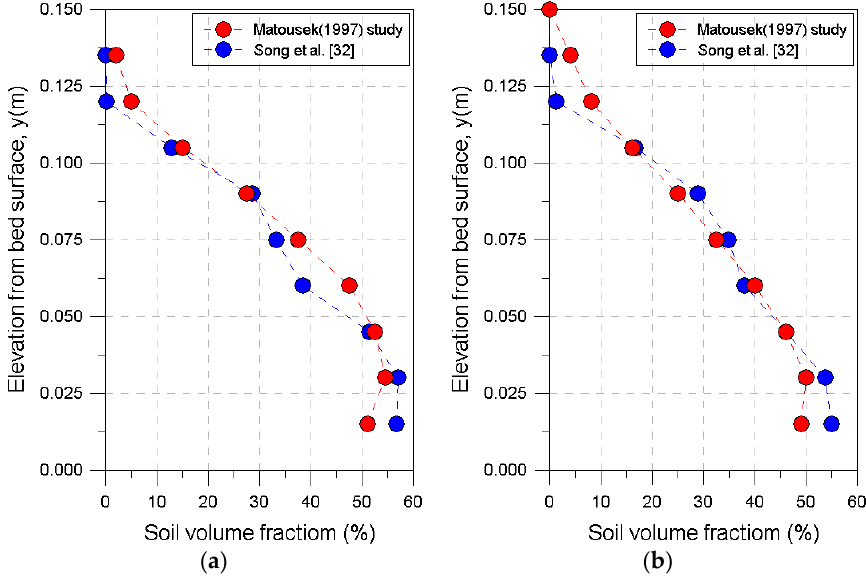
Figure 1. Comparison of modeling results by Song et al. [32], with earlier experimental data [50]. ( a ) flow velocity: 2.5 m / s; ( b ) flow velocity: 3.0 m / s.